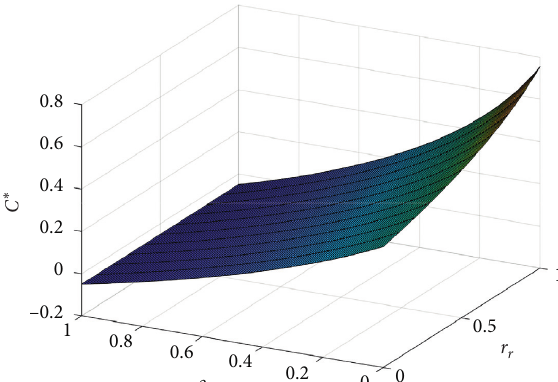
Figure 15: Effect of risk level β and unit residual value r water supply chain.